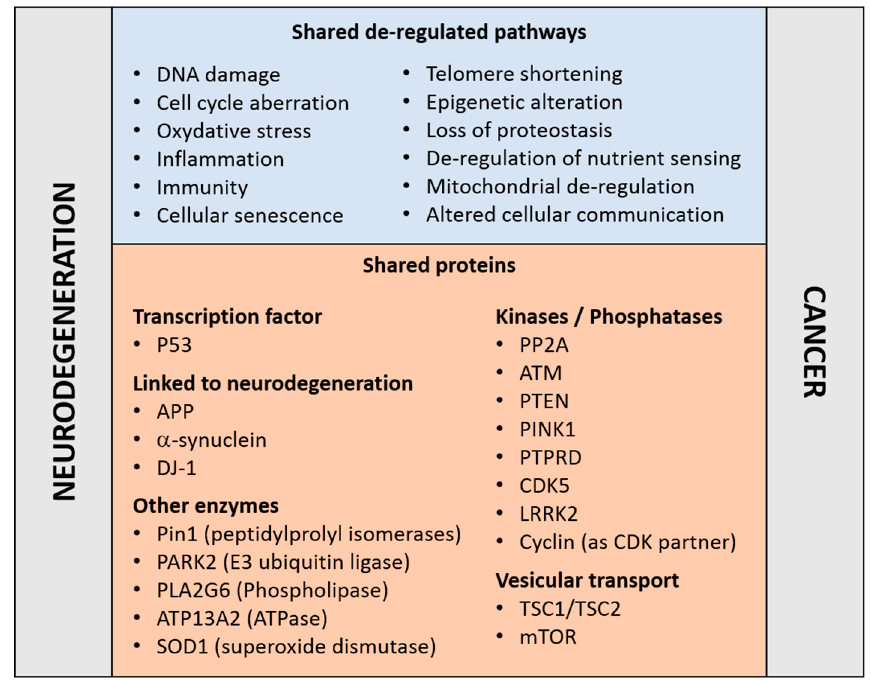
Figure 1. Molecular pathways (top) and proteins (bottom) that have been linked to cancer and neurodegenerative disorders, details and references are given in the main text.